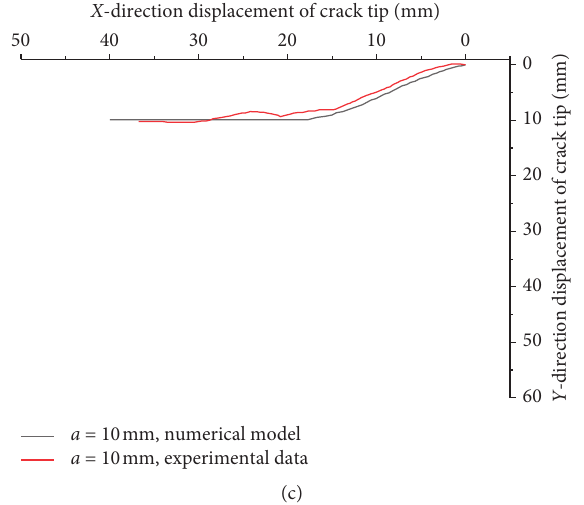
Figure 21: Comparison of the crack paths for different precrack locations. (a) a � 0mm. (b) a � 5mm. (c) a � 10